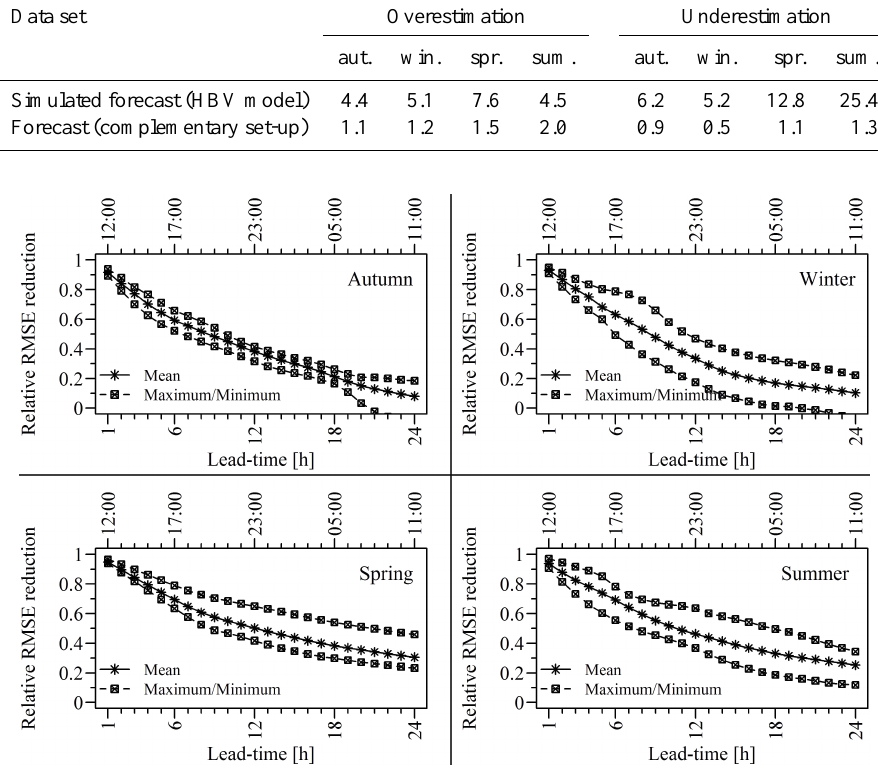
Figure 6. Summary of relative seasonal RMSE reductions as a function of forecast lead time (minimum, mean and maximum values com- puted from corresponding computations for the hydrologic years